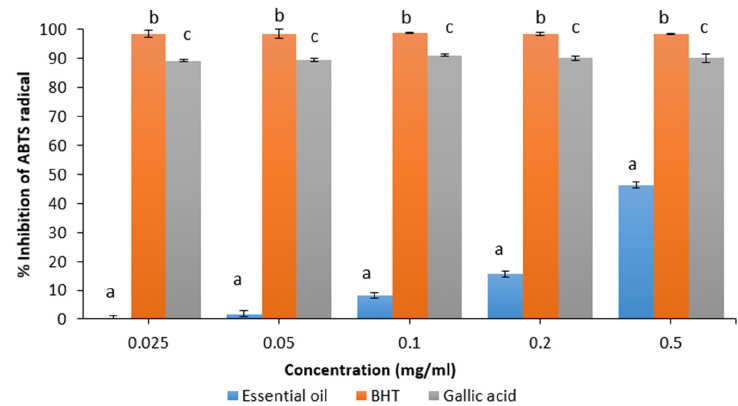
Figure 3. ABTS radical scavenging activity of the essential oil of H. africana. Bar graphs with different letters within the same concentration are significantly different ( p < 0.05).